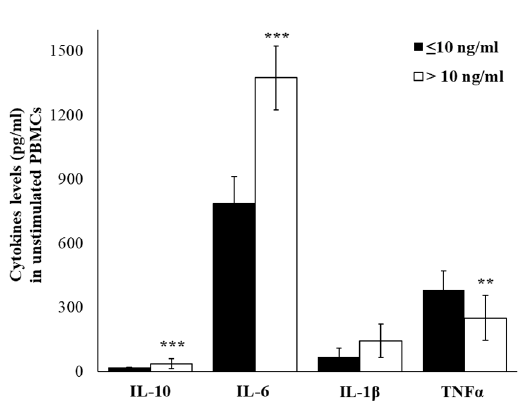
Figure 4. Basal cytokine production. IL-10, IL-6, IL-1 β , and TNF α levels in supernatants of untreated PBMCs of enrolled workers with salivary cortisol levels ≤ or > of 10 ng/mL. Data are reported as mean ± S.D. ** p -value ≤ 0.01; *** p -value ≤ 0.001.